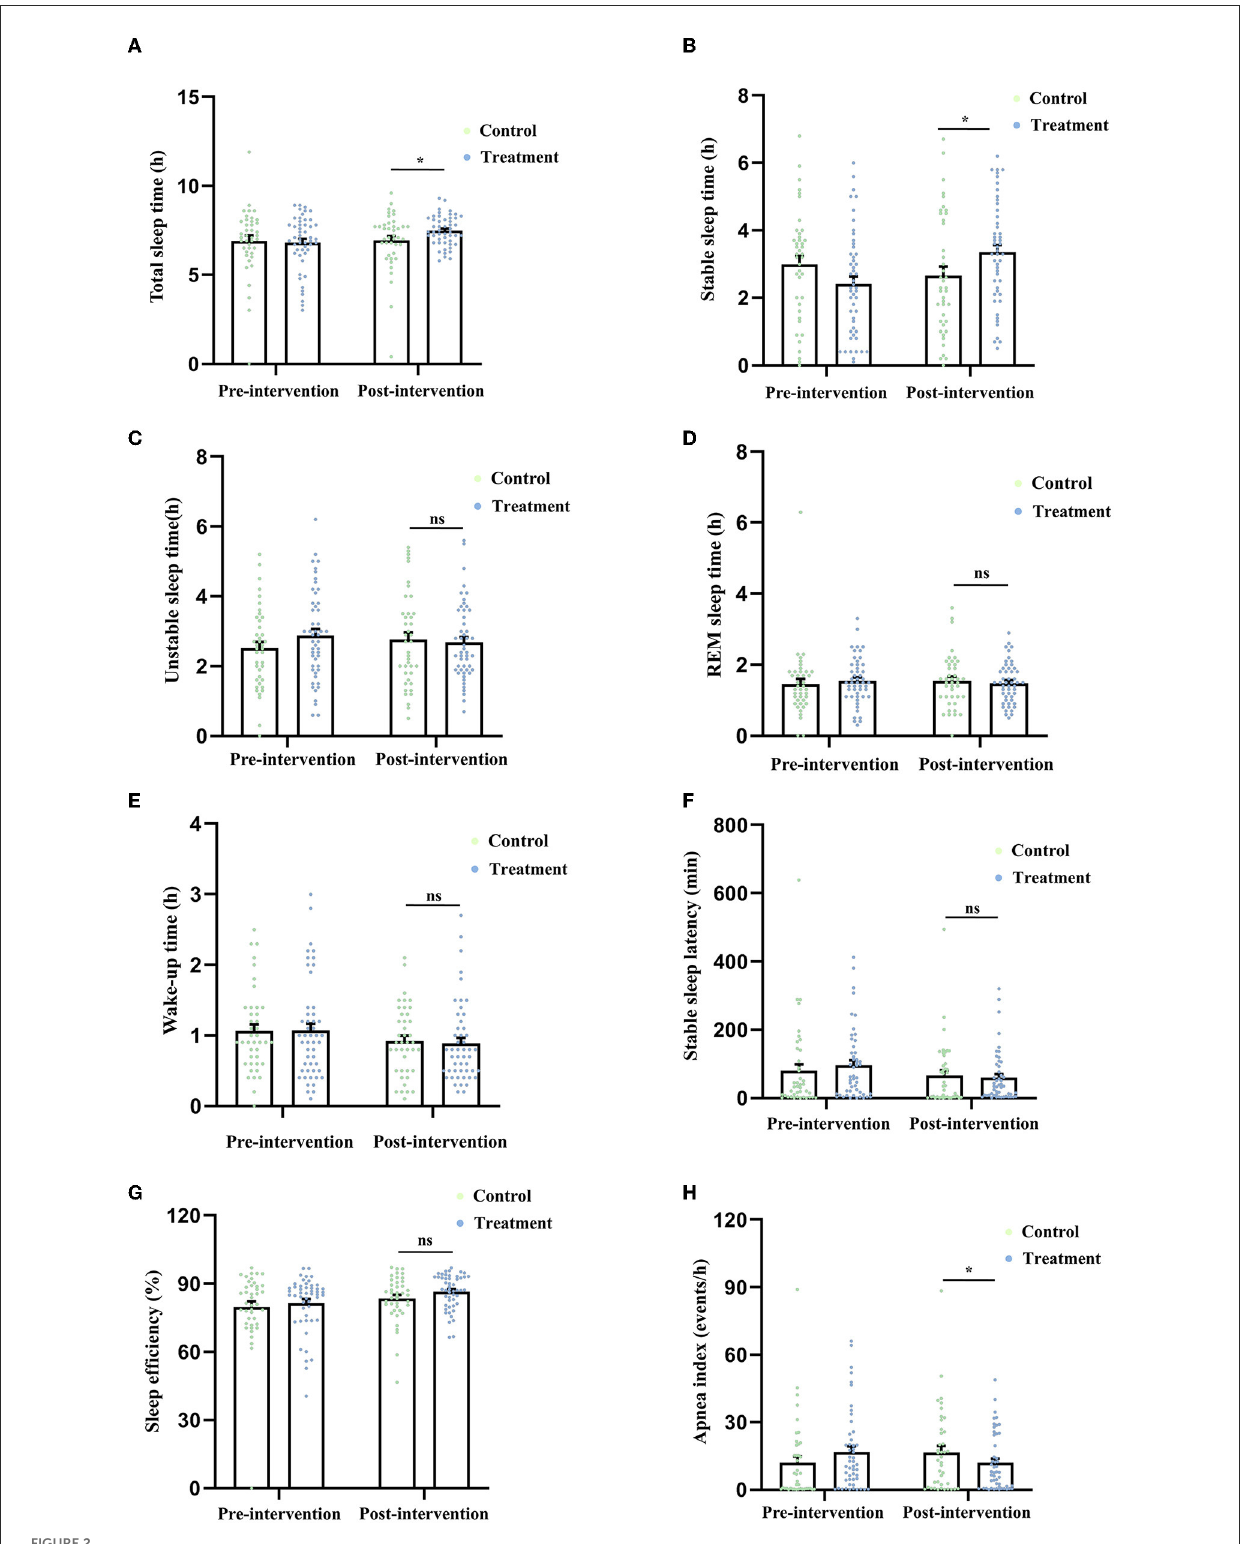
FIGURE2 Comparison of the indicators related to sleep quality derived from the CPC technique, including total sleep time (A) , stable sleep time (B) , unstable sleep time (C) , REM sleep time (D) , wake-up time (E) , stable sleep latency (F) , sleep efficiency (G) , and apnea index (H) between the two groups after 2-week treatment. * P < 0.05 was considered statistically significant. ns, no